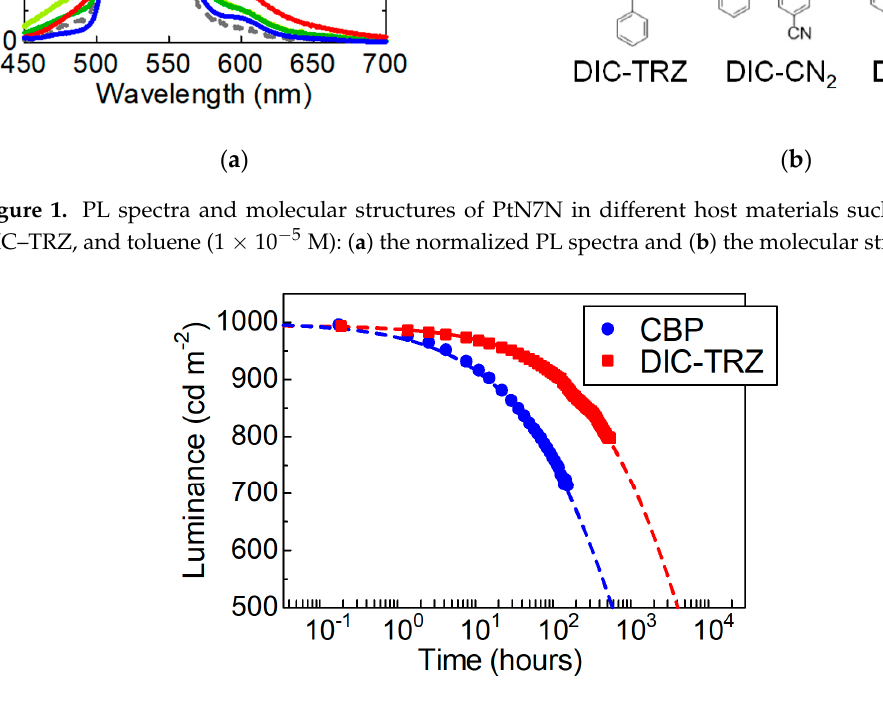
Figure 2. Luminance–time characteristics for the PtN7N devices fabricated using different host materials under a constant current with an initial luminance of 1000 cd m − 2 .